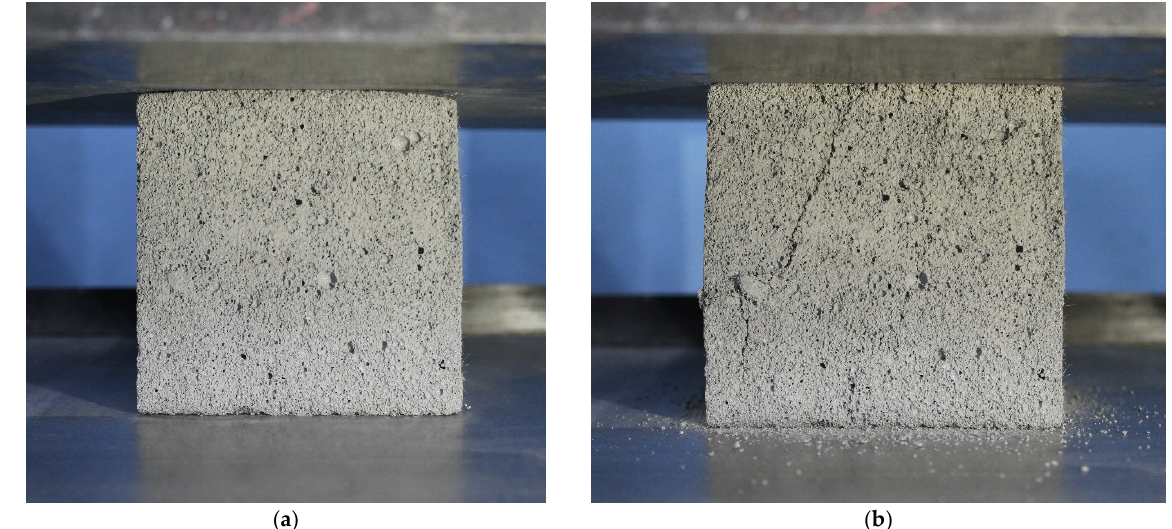
Figure 4. CS testing of FFC specimens: ( a ) during loading; ( b ) after collapse.